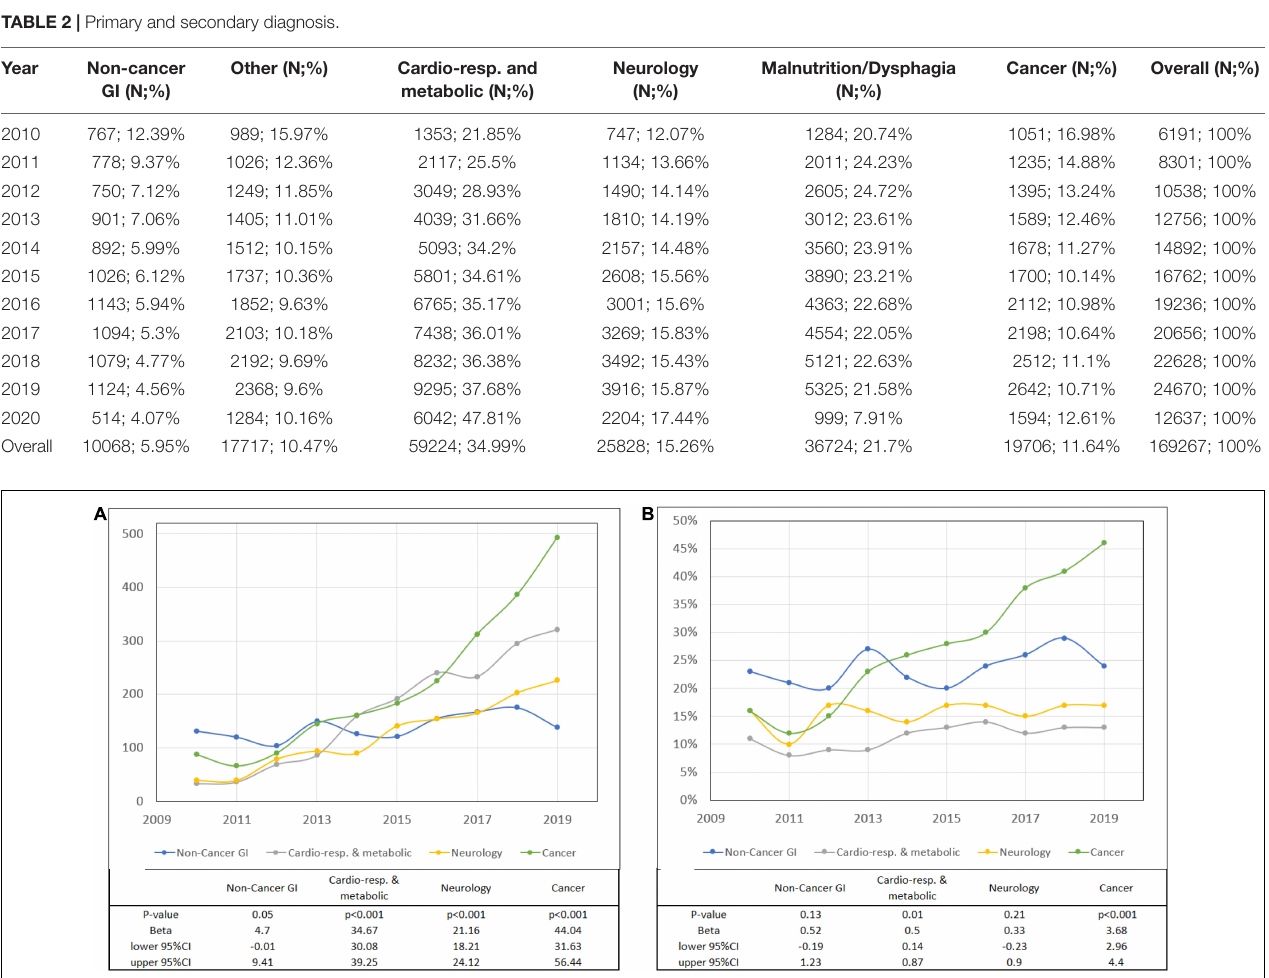
Frontiers in Nutrition |